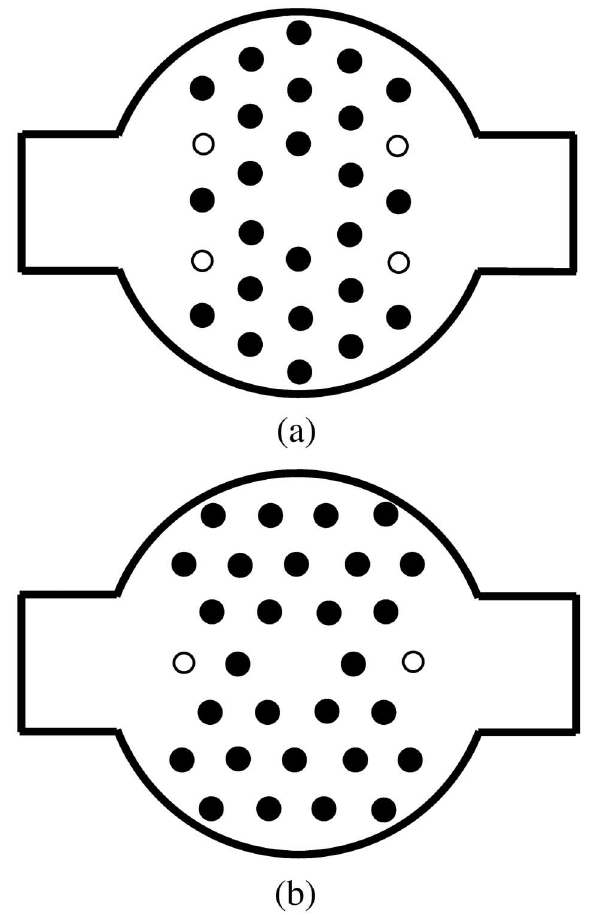
FIG. 3. (a) “Side” coupling scheme: partially withdrawn rods are shown as hollow circles while the rods shown as solid black dots form the actual cavity. (b) “Vertex” coupling